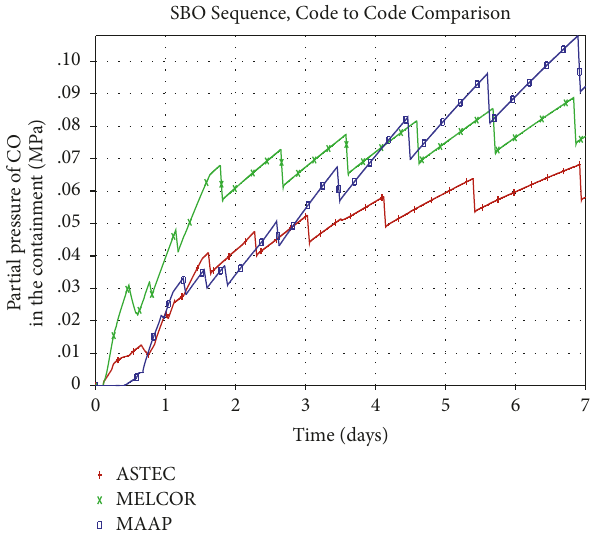
Figure 12: Partial pressure of carbon monoxide in the